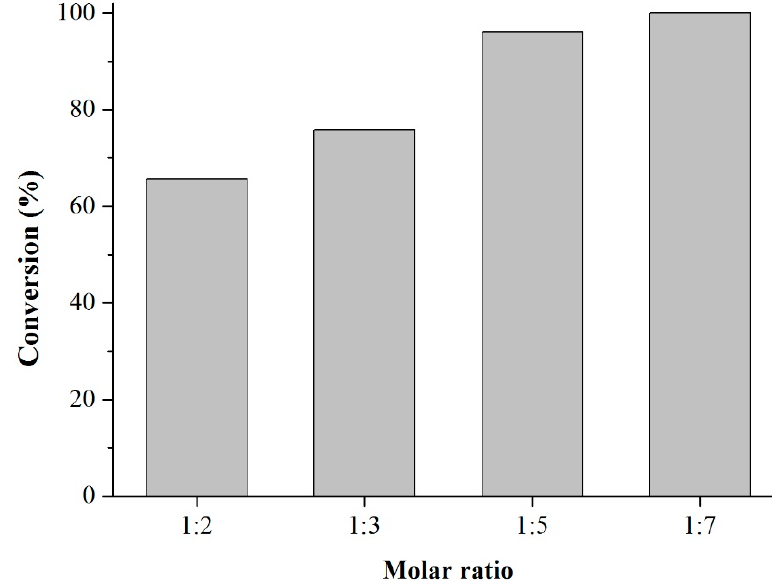
Figure 9. Effect of the molar ratio between the reactants (EugOH and AA). Conditions of the esterification reaction: reaction time 40 min, temperature 80 °C and 2% of catalyst.